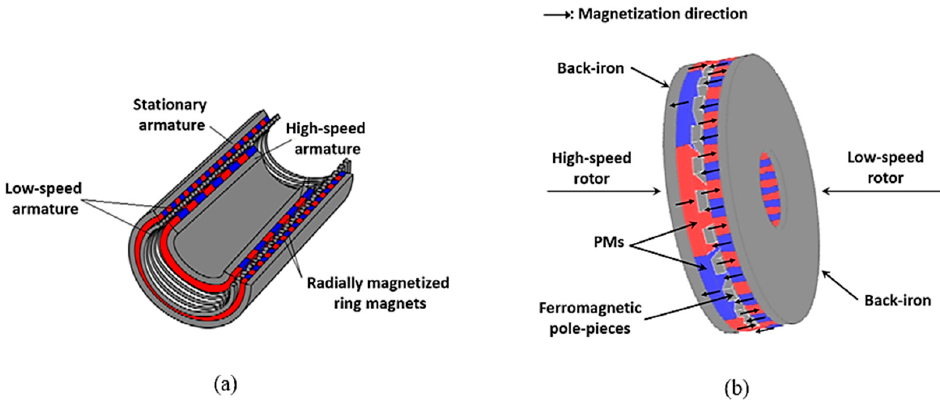
Figure 9. Magnetic gear: ( a ) Topology with linear design; ( b ) Axial flux topology.